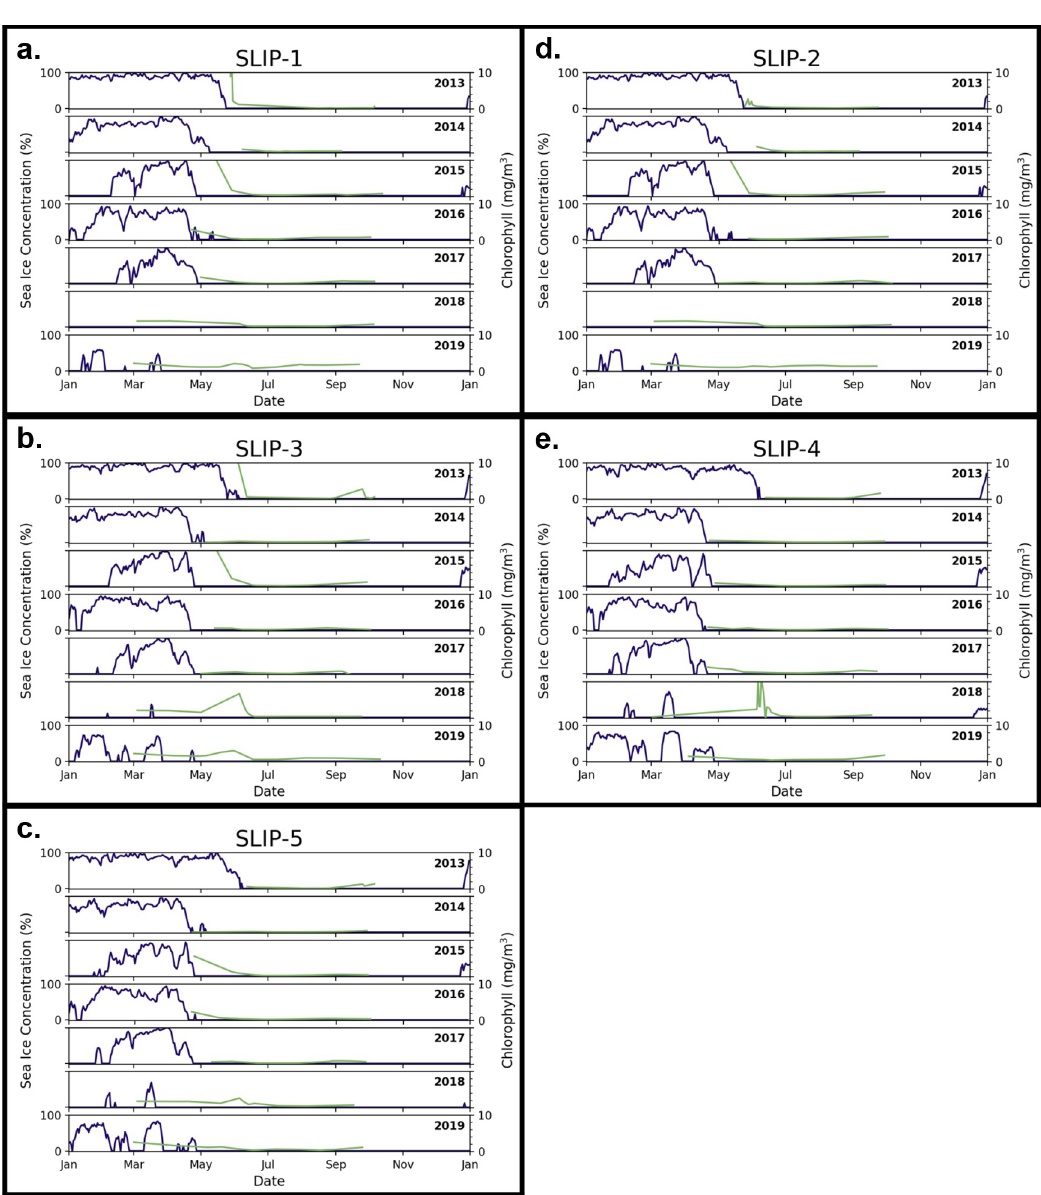
Fig 5. Daily sea ice concentrations (blue) and MODIS chlorophyll a (green) time series curves at the DBO1